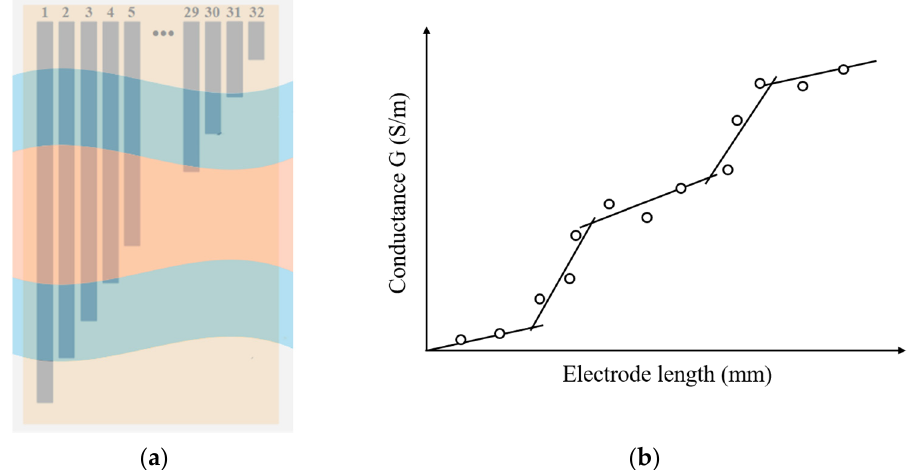
Figure 13. ( a ) Five phase media along the sensor with un-planar interfaces; ( b ) Linear piecewise relationship between conductance and increasing length for un-planar interfaces scenario.